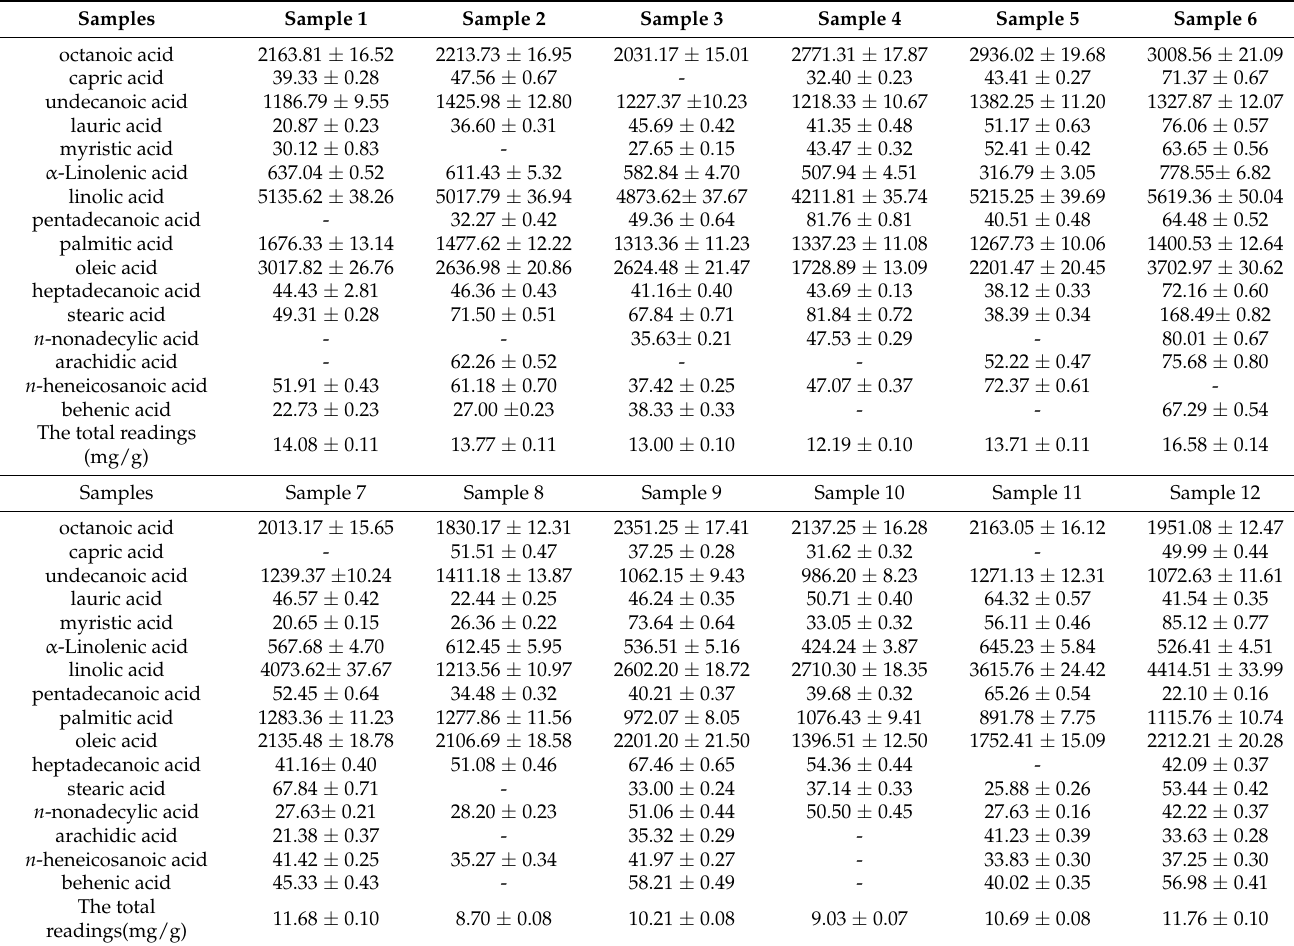
Table 7. The contents of fatty acids from Potentilla anserina L. by SFE ( µ g/g, n =